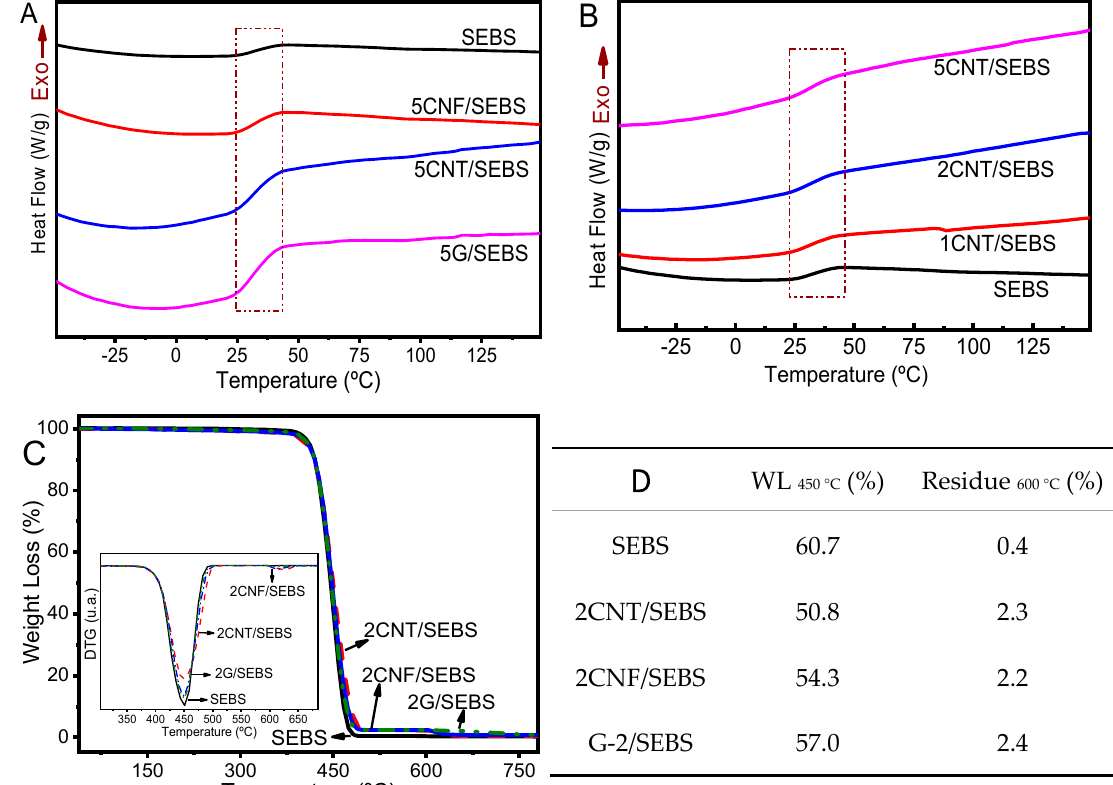
Figure 4. ( A , B ) DSC thermograms for SEBS and its composites with different carbonaceous nanofillers; ( C ) TGA and DTG of the SEBS and its nanocomposites with 2 wt.% of the different